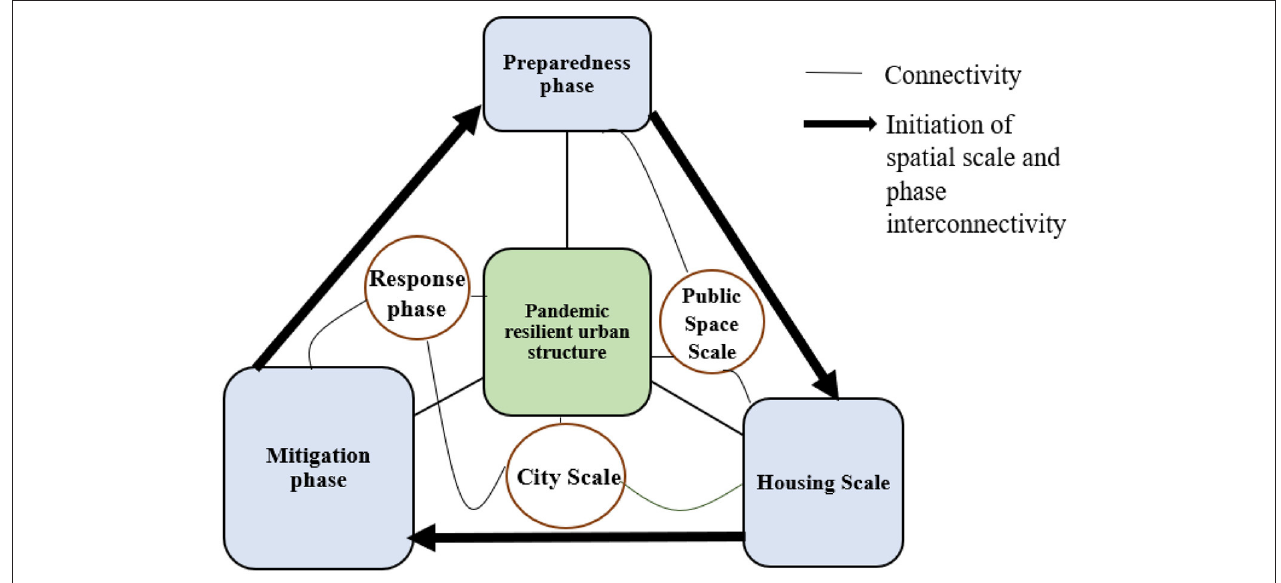
FIGURE 3 | The proposed framework of pandemic-resilient urban feature associated with three spatial scales and disaster risk management